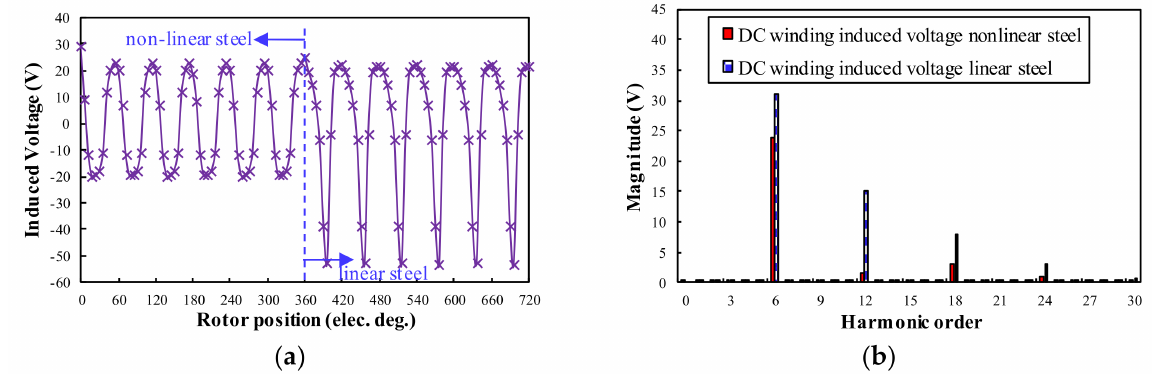
Figure 11. On-load DC winding induced voltage waveforms and spectra for 12/4 WRSM: ( a ) Wave- forms; ( b ) Spectra.